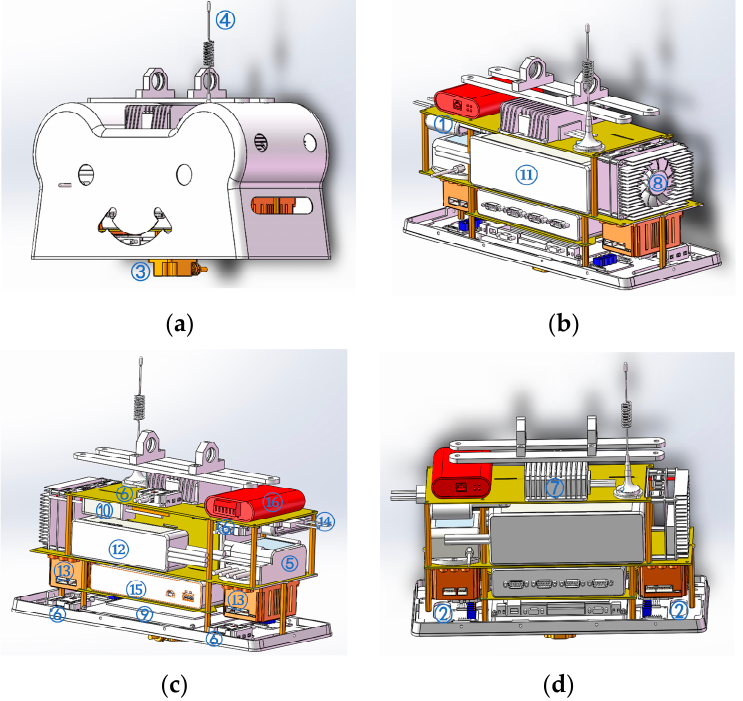
Figure 3. The layout of on-board equipment. The main equipment is numbered according to Table 3. ( a ) Base link appearance. ( b ) Inside oblique drawing ( left ). ( c ) Inside oblique drawing ( right ). ( d ) Inside oblique drawing. Table 3. On-board Equipment.